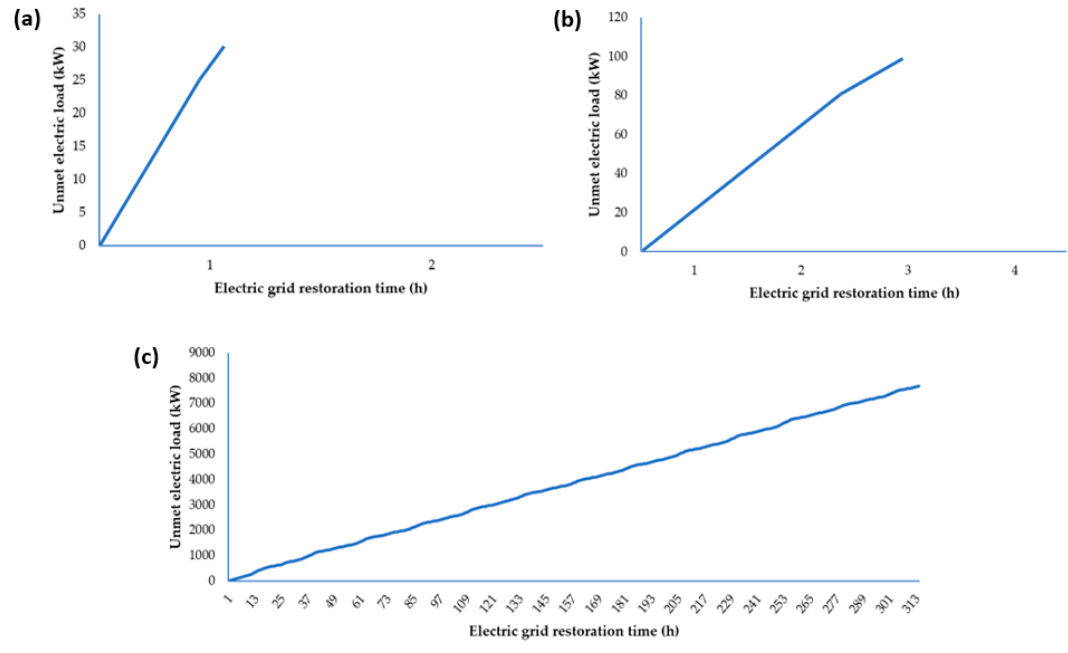
Figure 12. The increasing trends of unmet electric load profile vs. electric grid restoration time: ( a ) outage-1 (intentional attack); ( b ). outage-2 (system operational error); ( c ). outage-3 (fuel supply issue). Table 5. Techno-economic and environmental indicators of a power supply system without any backup energy storage or generation